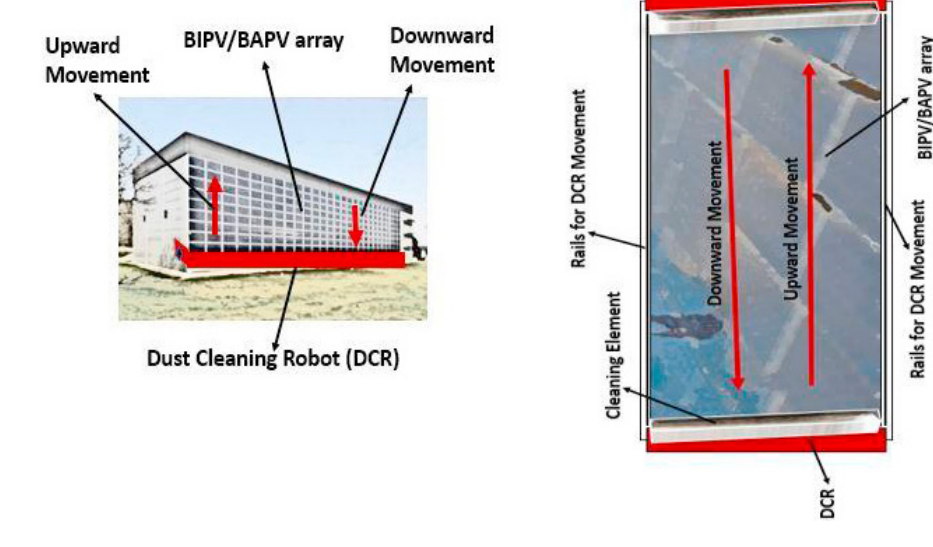
Figure 22. Adjustment of DCR on BIPV facade [62].